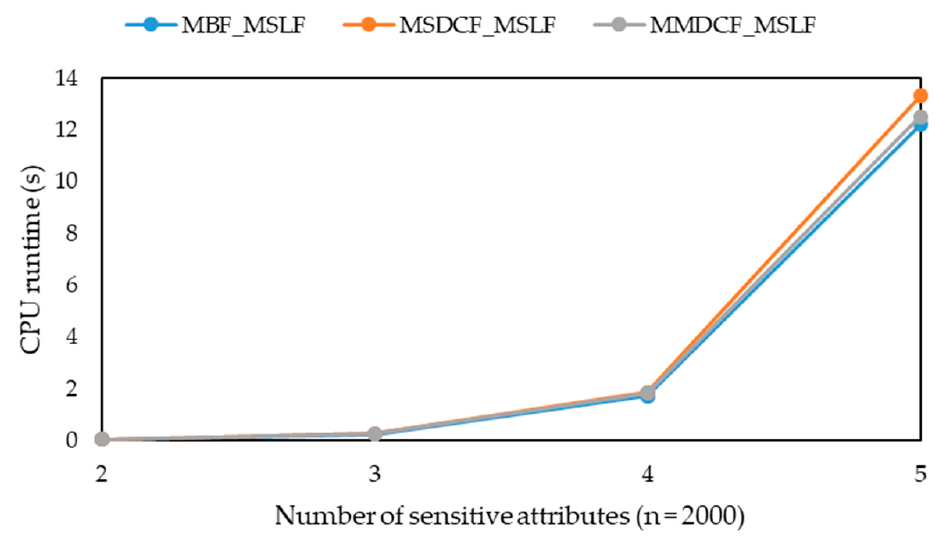
Figure 23. The CPU runtime of MBF-MSLF, MSDCF-MSLF and MMDCF-MSLF with different sensitive attribute numbers ( n = 2000).